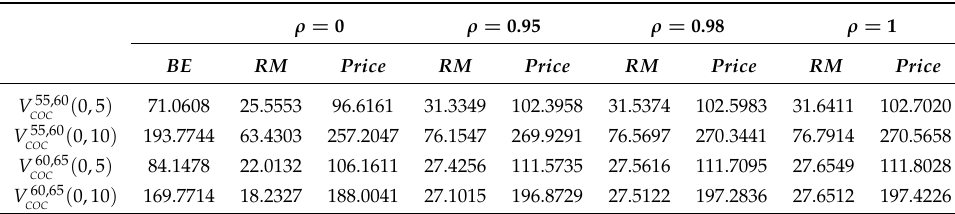
Table 6. The prices of the different GS-forwards for different ages, maturities, and correlations, Cost of Capital (COC) approach. ρ = 0 ρ = 0.95 ρ = 0.98 ρ = 1